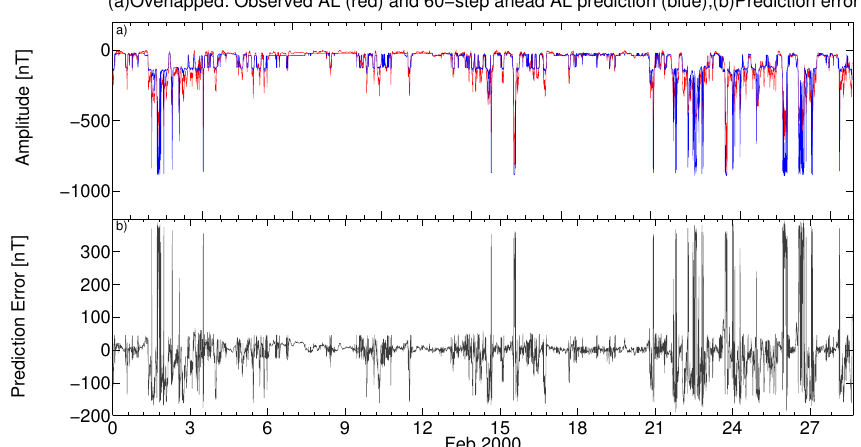
Fig. 7. (a) AL observation (red) and predicted AL (blue) – 60 step ahead prediction; (b) prediction error. The panel shows one month of data (February 2000) at 1min